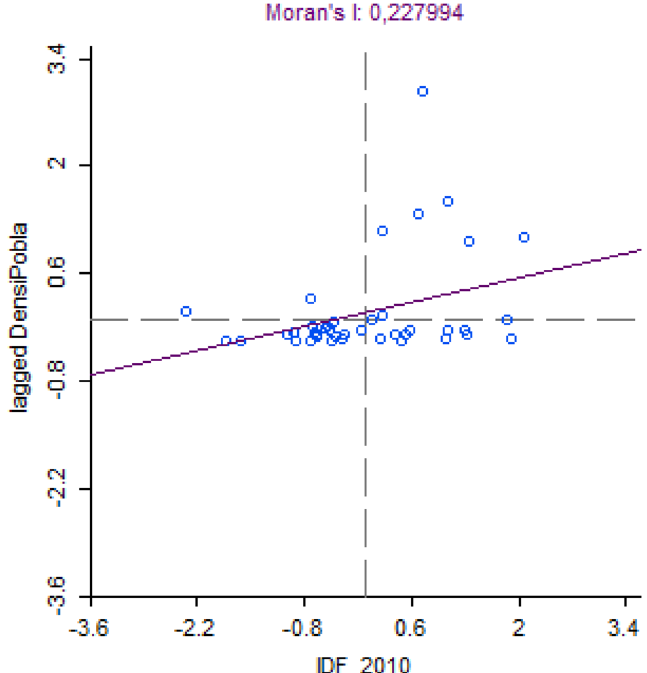
Fig. 6 Global Moran Index for the fiscal efficiency (IDF_2010) and the categorization of the area (by population density). Source: own computation based upon GeoDa (2020)